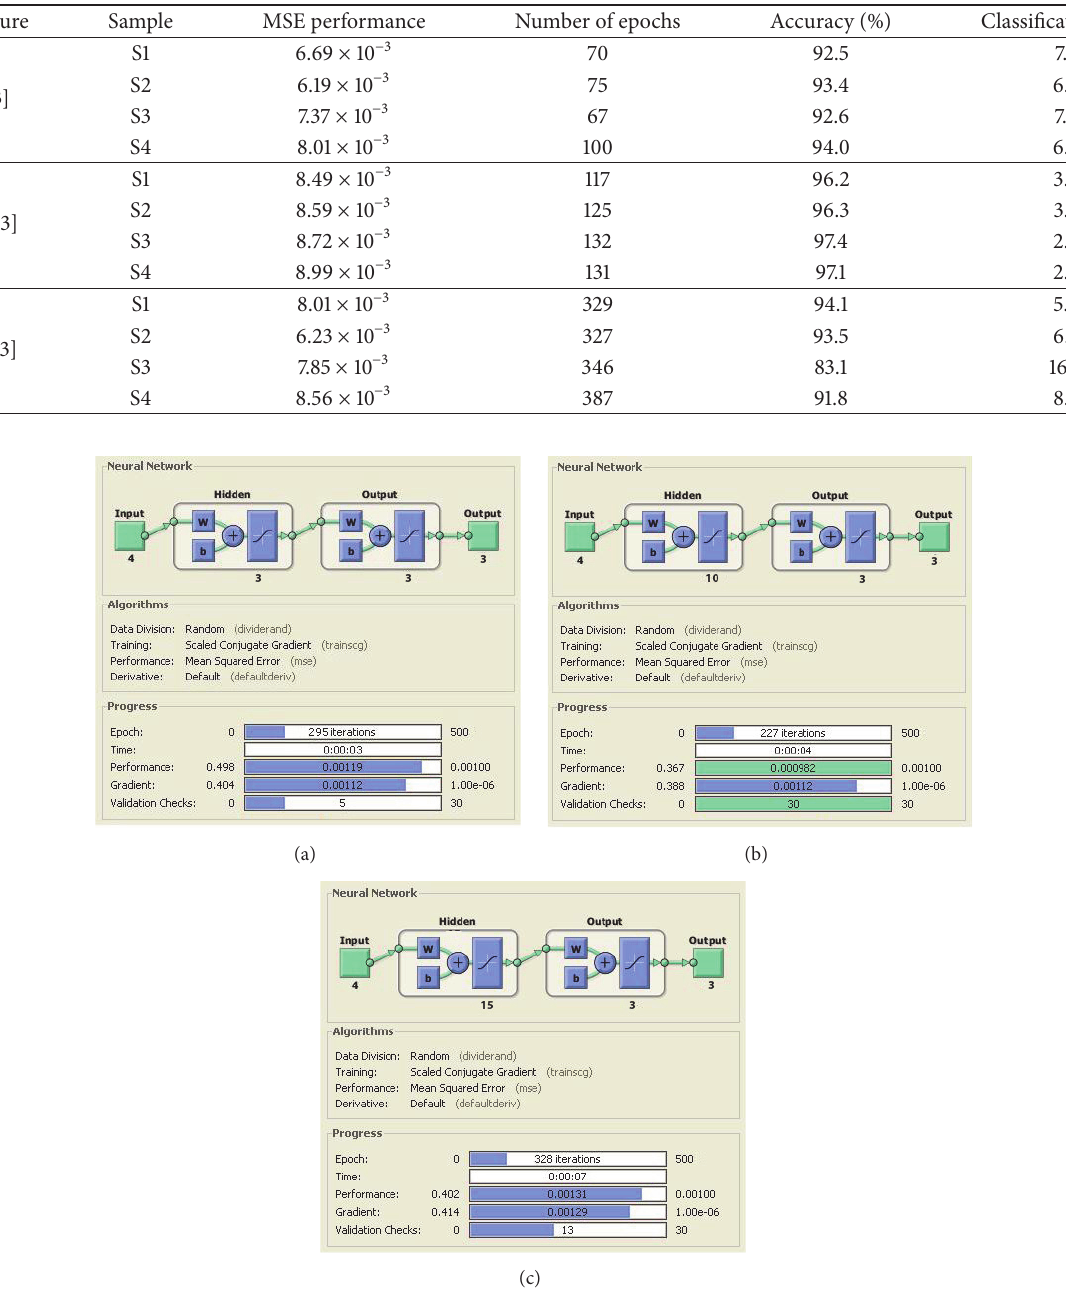
Figure 9: Overview of the different ANN architectures chosen for fault diagnosis. (a) [4 × 3 × 3]; (b) [4 × 10 × 3]; (c) [4 × 15 × 3].